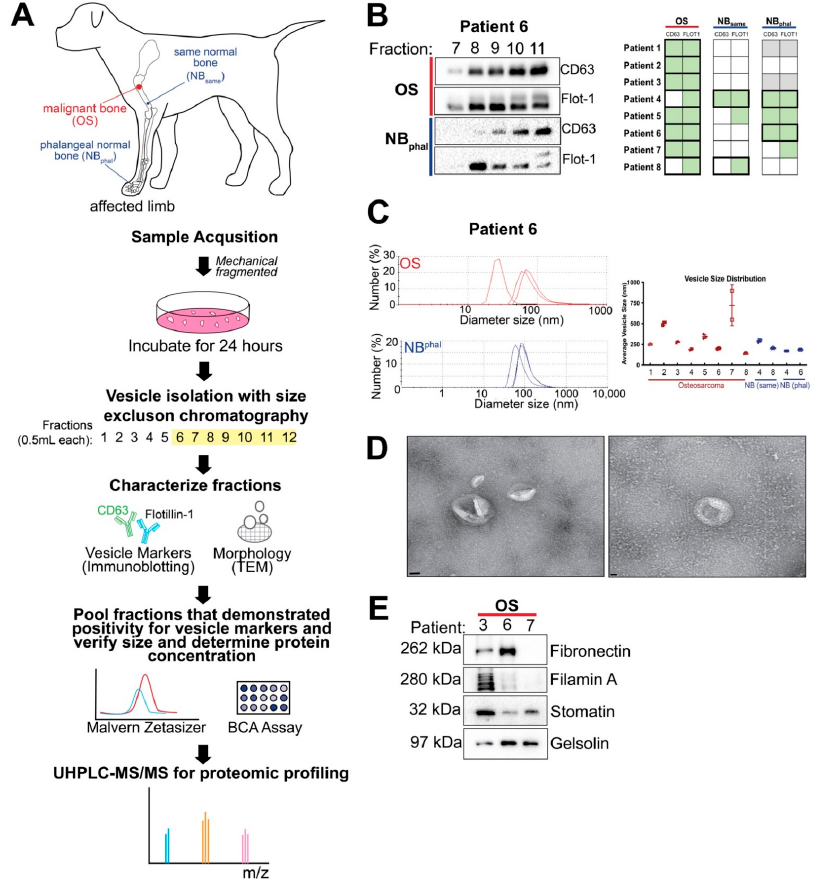
Figure 1. Isolation and characterization of extracellular vesicles from OS and non-malignant bone tissue explants. ( A ) General workflow for sample acquisition and vesicle characterization from canine appendicular OS patients. ( B ) Representative immunoblot for extracellular vesicle markers, CD63 and flotillin-1 (Flot-1) for patient 6 (left) and table summarizing immunoblot results for all patients (right). Green filled boxes represent positivity for the marker, empty boxes represent no signal detected for the marker, grey filled boxes indicate the sample was not obtained. Bold outlines represent the samples that were included in the UHPLC-MS/MS analysis as they were positive for CD63 and/or flotillin and had a total protein concentration of 2.9 µ g ( n = 12). ( C ) Representative size distribution analysis for pooled fractions that were CD63 and/or flotillin-1-positive for patient 6 (left) and summary graph of vesicle size distribution for all patients (right). ( D ) Representative transmission electron microscopy images of a vesicle preparation obtained with our protocol; scale bar = 50 nm (left) or 20 nm (right). ( E ) Immunoblots of OS samples from patients 3, 6, 7 for novel vesicle markers fibronectin, filamin A, stomatin and